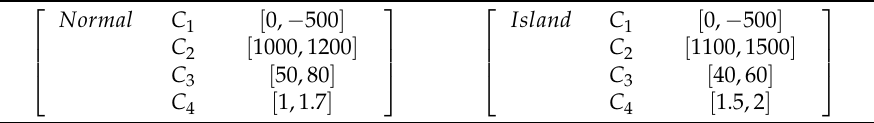
Table 1. Extension element model showing when islanding will occur.